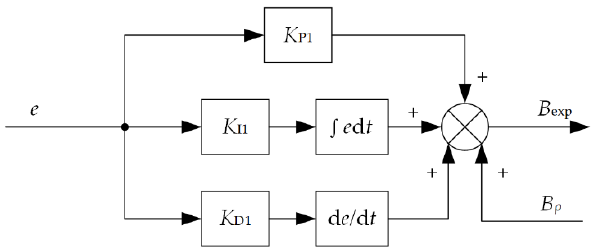
Figure 6. Proportional–integral–derivative (PID) depth controller block diagram.